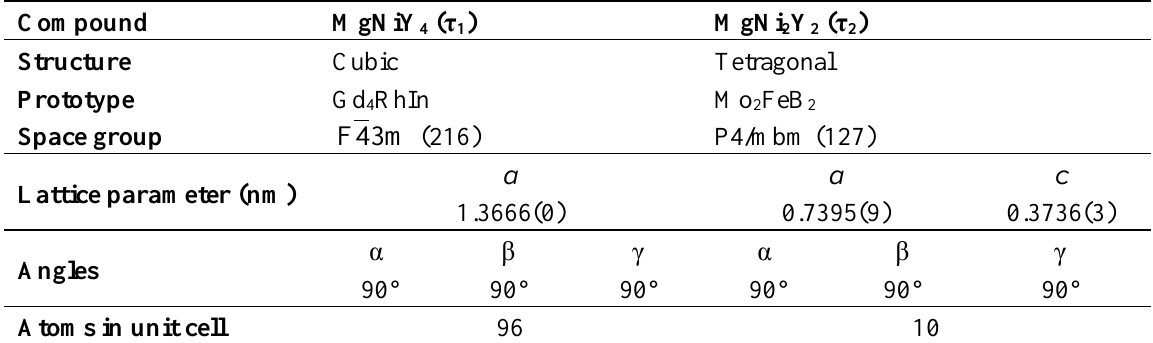
Table 3. The crystal structure data of τ 1 and τ 2 .